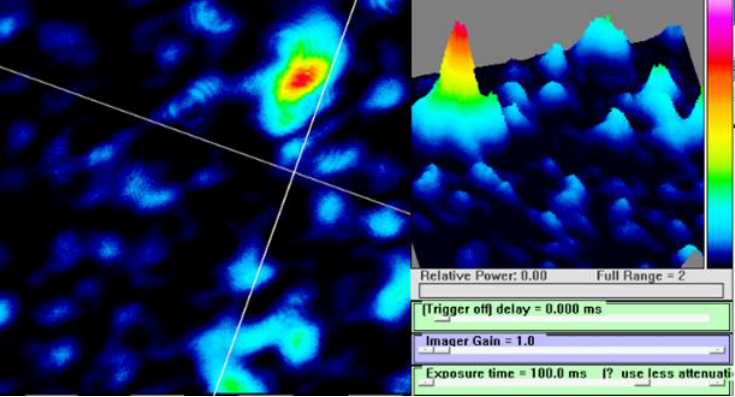
Figure 7: The concentrations of dust